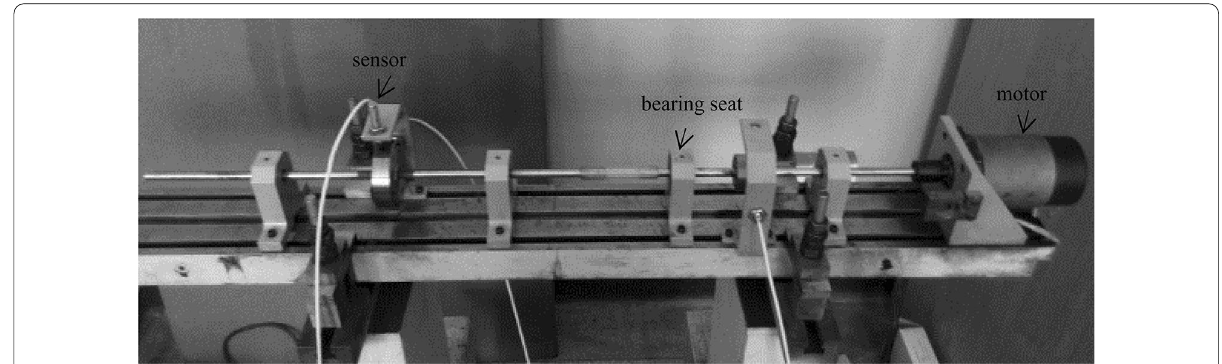
Figure 14 ZT-3 rotor test bench